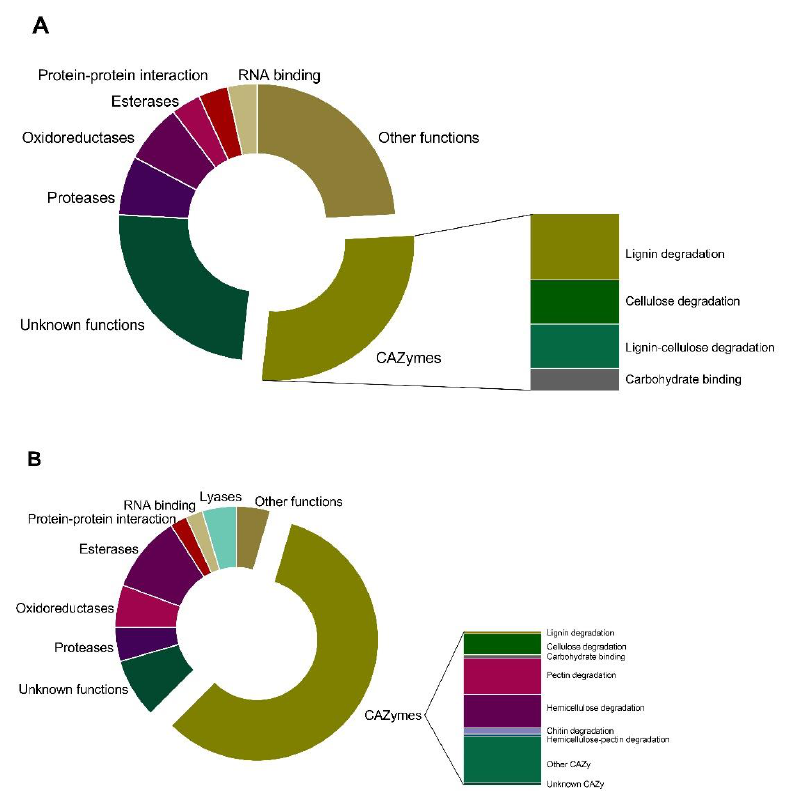
Figure 1. Functional classification (GO, Molecular Function) of the extracellular proteins secreted by N. parvum whose abundance was significantly different ( p < 0.05) between the two conditions. ( A ) Proteins less abundant in the presence of the Eucalyptus stem, and ( B ) Proteins more abundant in the infection-like condition. For each category, the number of proteins is reflected by the size of the pie slice. The classification was obtained from the GO annotation at the UniProt database [40] . When lacking exact functional annotations in UniProt, the family and domain databases InterPro and Pfam [42,53] were used to reveal annotations of the identified proteins of conserved domains. 3.2. Protein — Protein Interaction Due to the lack of data available on the proteome sequence of E. globulus , the refer- ence proteome for E. grandis (a closely related species) was used. Protein – protein